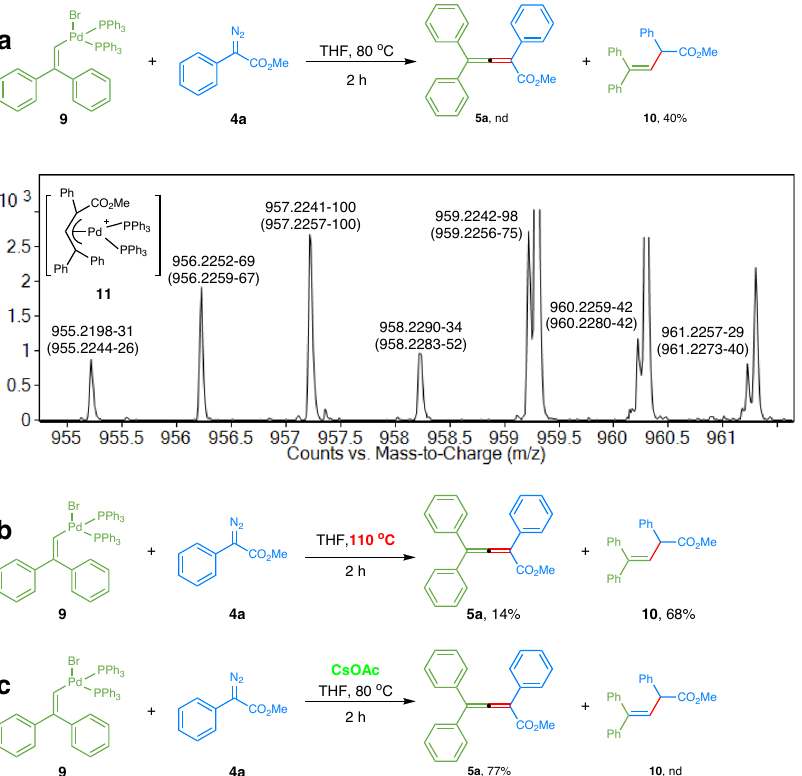
Fig. 6 Control experiments with palladium complex. a Reaction of palladium complex 9 and diazoacetate 4a at 80 o C in the absence of base. b Reaction of palladium complex 9 and diazoacetate 4a at 110 o C in the absence of base. c Reaction of palladium complex 9 and diazoacetate 4a at 80 o C in the presence of